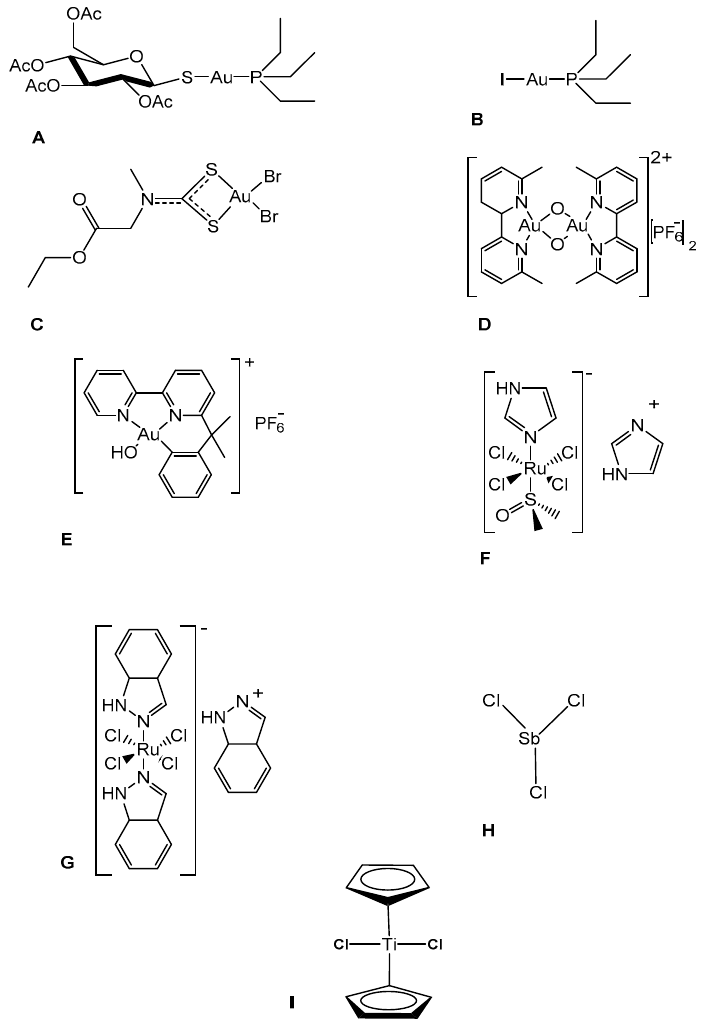
Figure 1. Chemical structures of the investigated complexes: ( A ) Auranofin; ( B ) the iodo-analogue of Auranofin, where the thiosugar is replaced by iodide ligand; ( C ) AuL12; ( D ) AuOXO6; ( E ) Aubipyc; ( F ) NAMI-A; ( G ) KP1019; ( H ) SbCl 3 ; ( I ) TiCp 2 Cl 2 (also known as Titanocene dichloride).